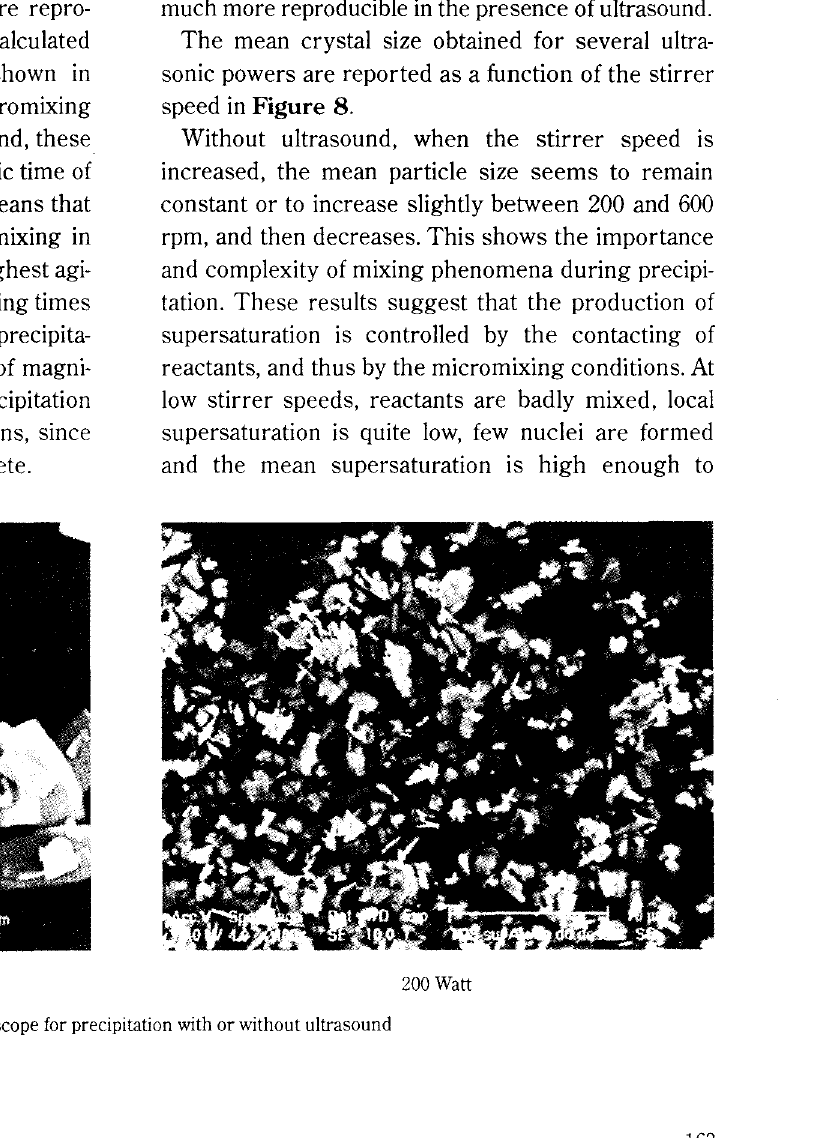
Micromixing times calculated from the segregation indexes remain rather high, and that the best micromixing is obtained at a high stirrer speed: 600 rpm for a 2-litre reactor. This is probably because the reactants are introduced at a very low point in the reactor Gust above the ultrasound transducer).